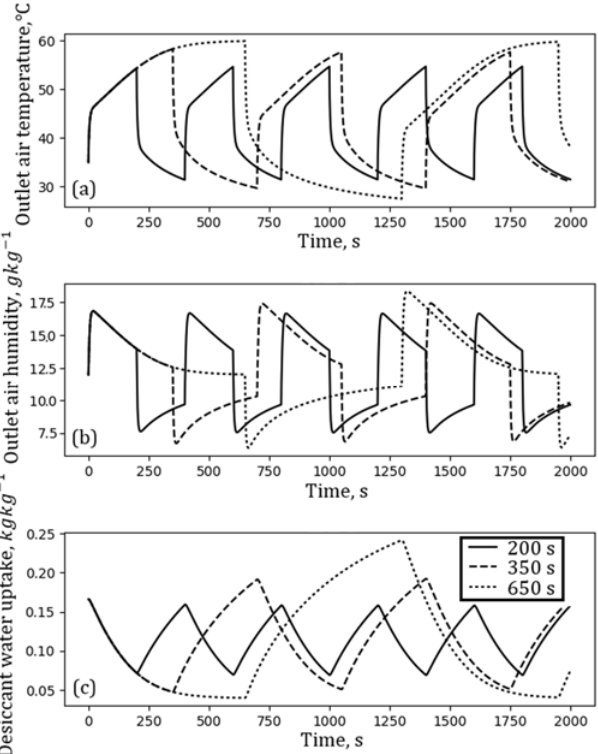
Figure 8. The influence of switching time on adsorption/desorption characteristics: ( a ) Outlet air temperature; ( b ) Outlet air humidity; and ( c ) Desiccant water uptake.